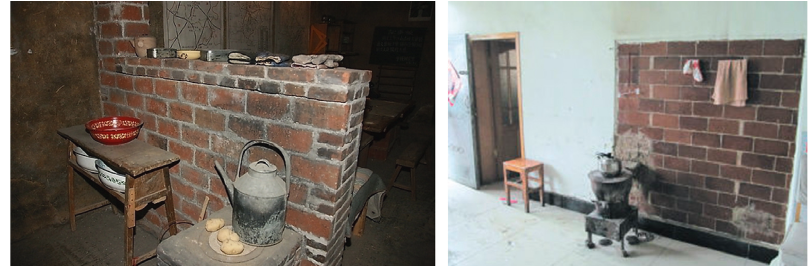
Figure 1: Traditional Chinese heated walls commonly used in northern China (photograph: left: http://www.huitu.com/photo/show/ 20121107/154758101200.html; right: